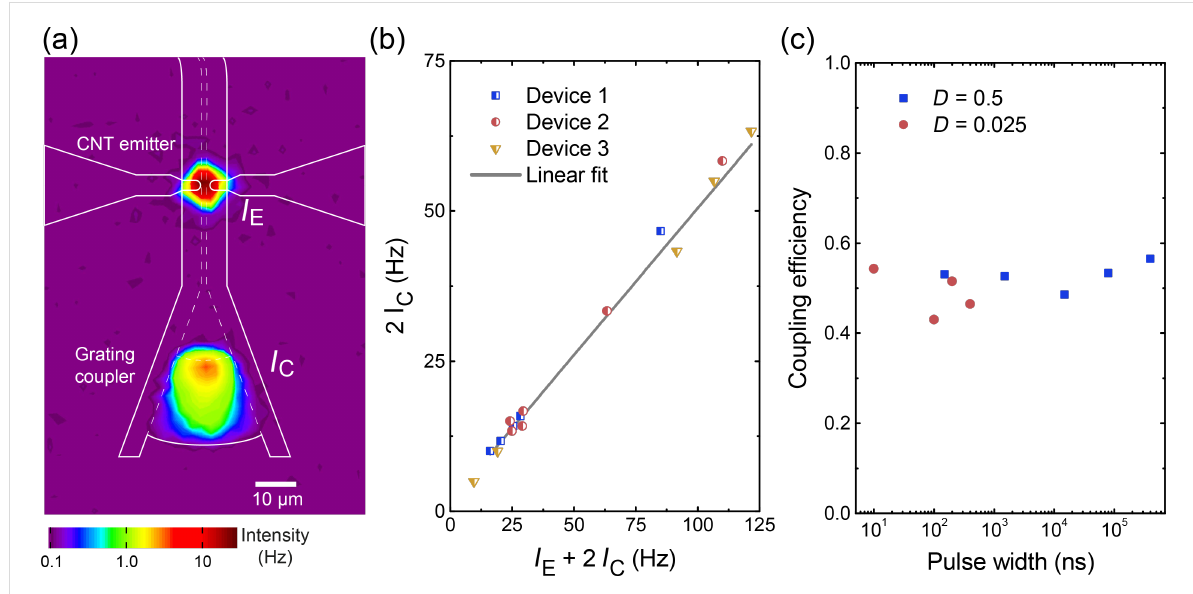
Figure 3: (a) Spatially resolved light emission showing intensity at the position of the CNT emitter and the grating coupler. The device geometry is in- dicated with white lines. The dashed lines mark the waveguide. (b) Integrated intensity recorded at the grating couplers 2I C over the sum of intensi- ties measured at the CNT emitter and grating couplers I E + 2I C . The data were collected for three devices (blue, red and yellow symbols) in the free- space setup. A linear fit to the data provides an average coupling efficiency η ≈ 0.48. (c) Coupling efficiency for pulsed emitters with duty cycles of 0.5 (blue symbols) and 0.025 (red